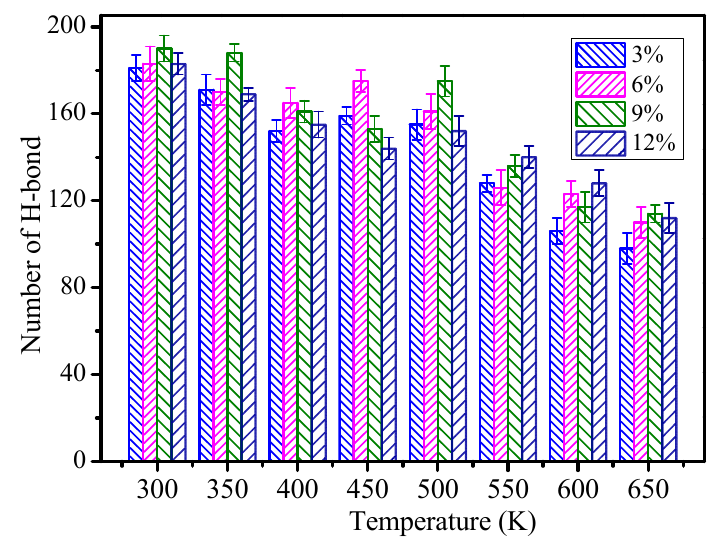
Figure 8. The number of hydrogen bonds of different grafting density models.